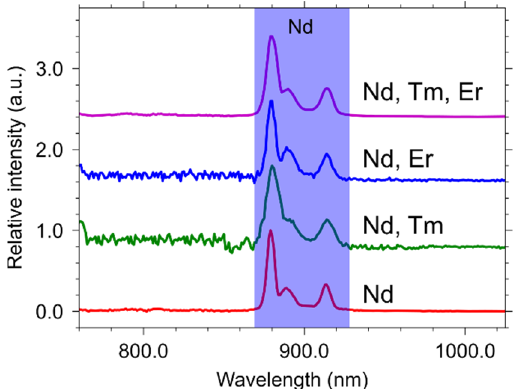
Figure 8. Emission spectra for the single-, double-, and triple-doped YVO 4 : Nd 3+ (0.03 at.%), Er 3+ (3 at.%), and Tm 3+ (1 at.%) samples under excitation with λ ex = 595